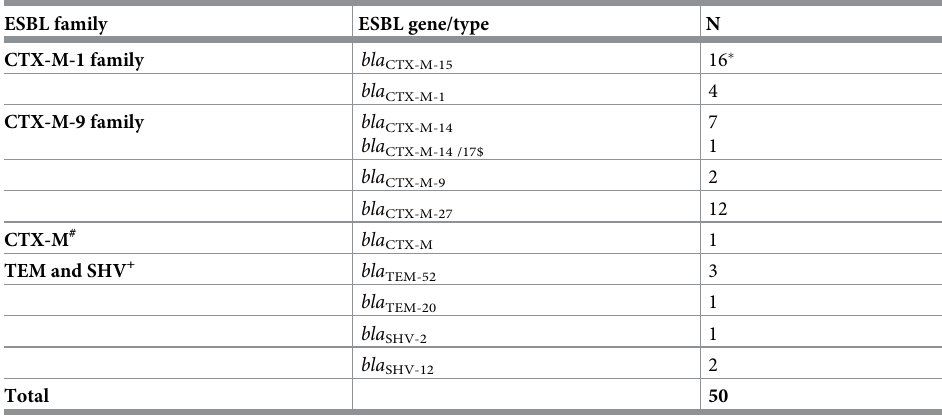
Table 3. ESBL-encoding genes (1 sequence per cluster, see